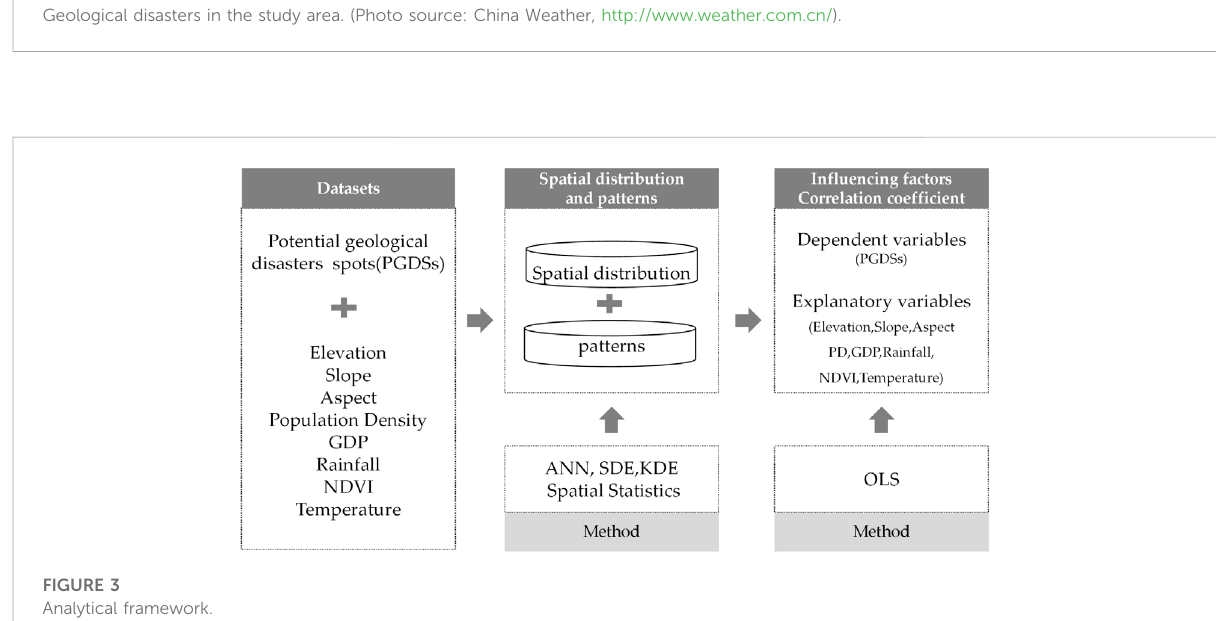
FIGURE 3 Analytical